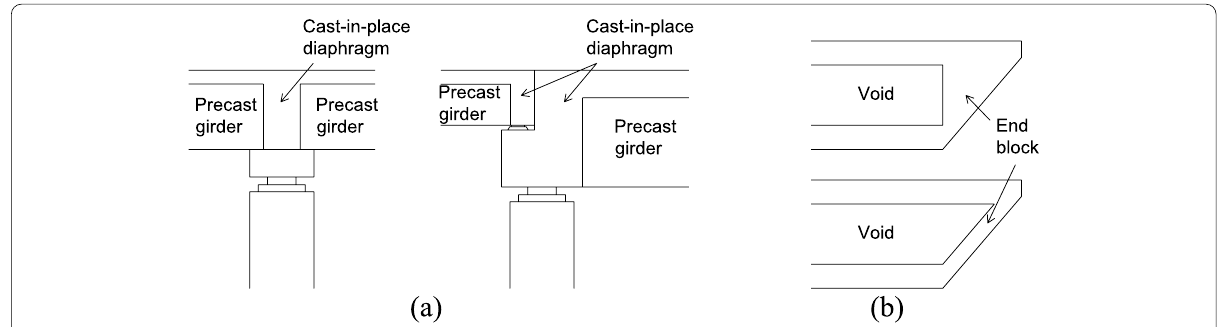
Fig. 3 End details of tub girders (reproduced from Cruz and Wisniewski [5]; TxDOT [13]): a cast-in-place diaphragms; b end block